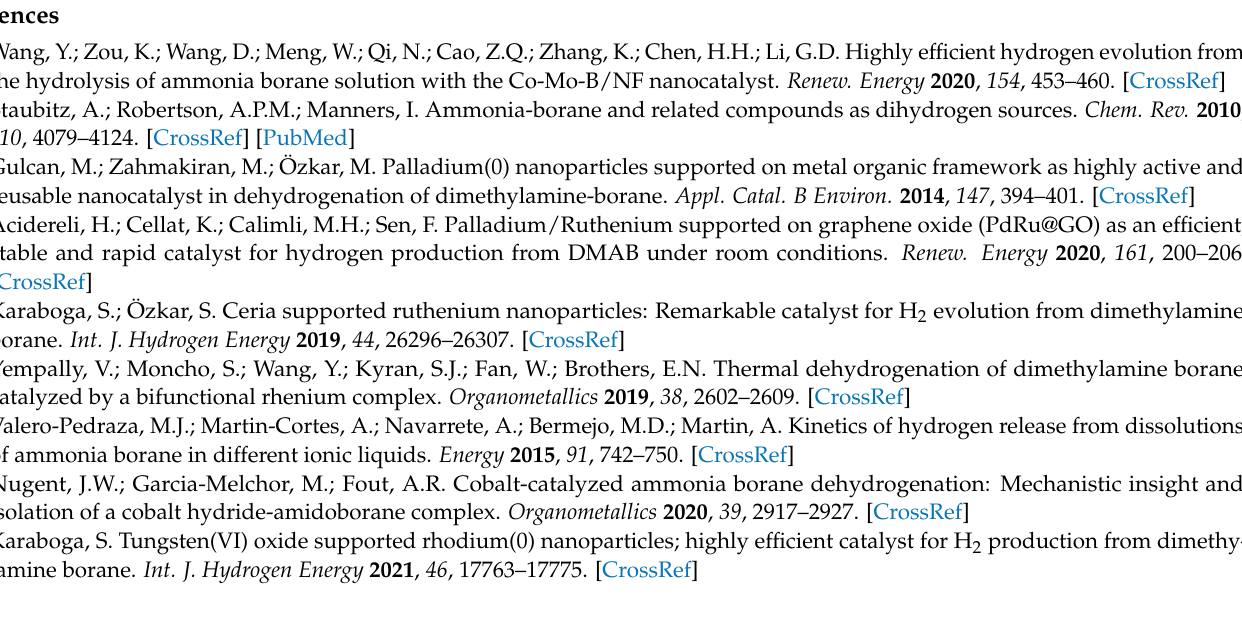
Rates, Figure S1. X-ray diffraction results of the hydrogels with various metal nanoparticles: and Figure S2. Representative volumes of hydrogen gas produced from Ni/Pd 30/1 with time over 160 min and the initial hydrogen volumes in the first 10